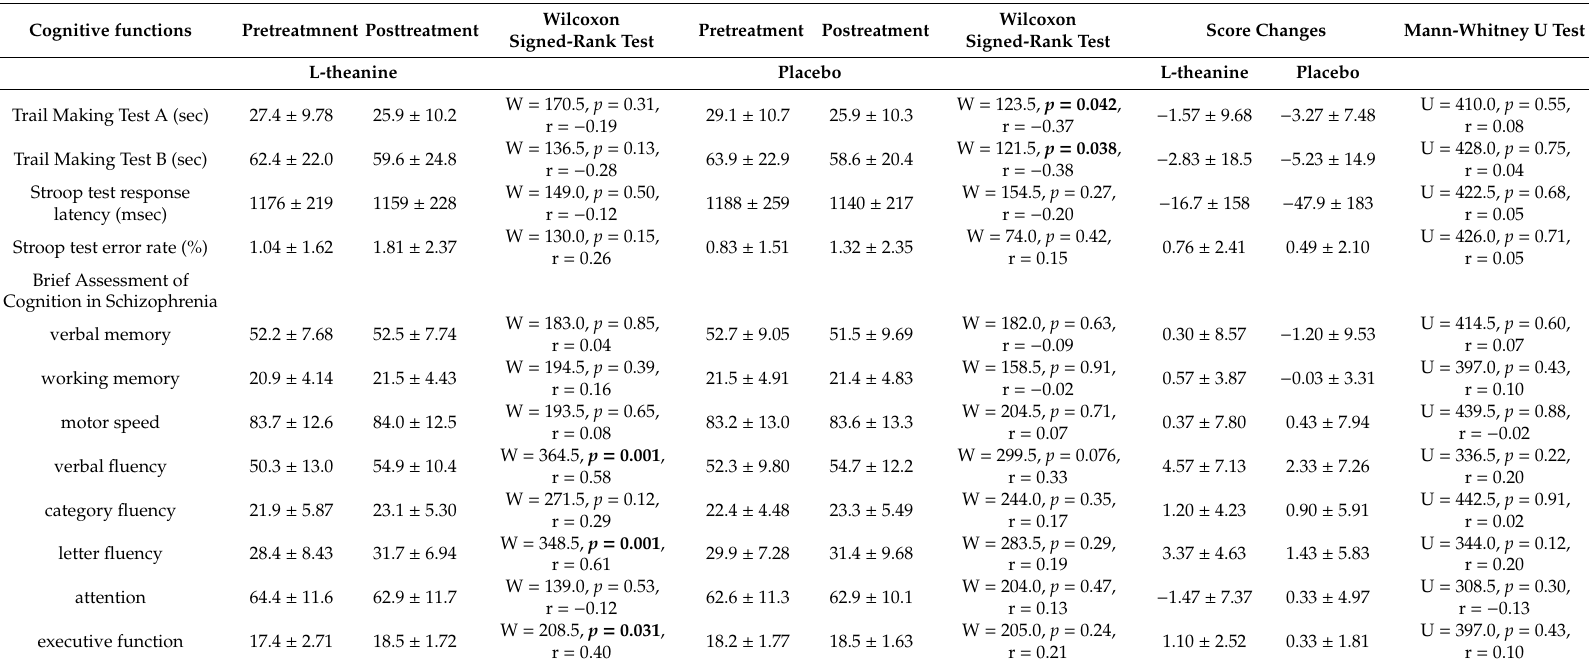
Table 3. The cognitive function scores after 4 weeks L-theanine or placebo